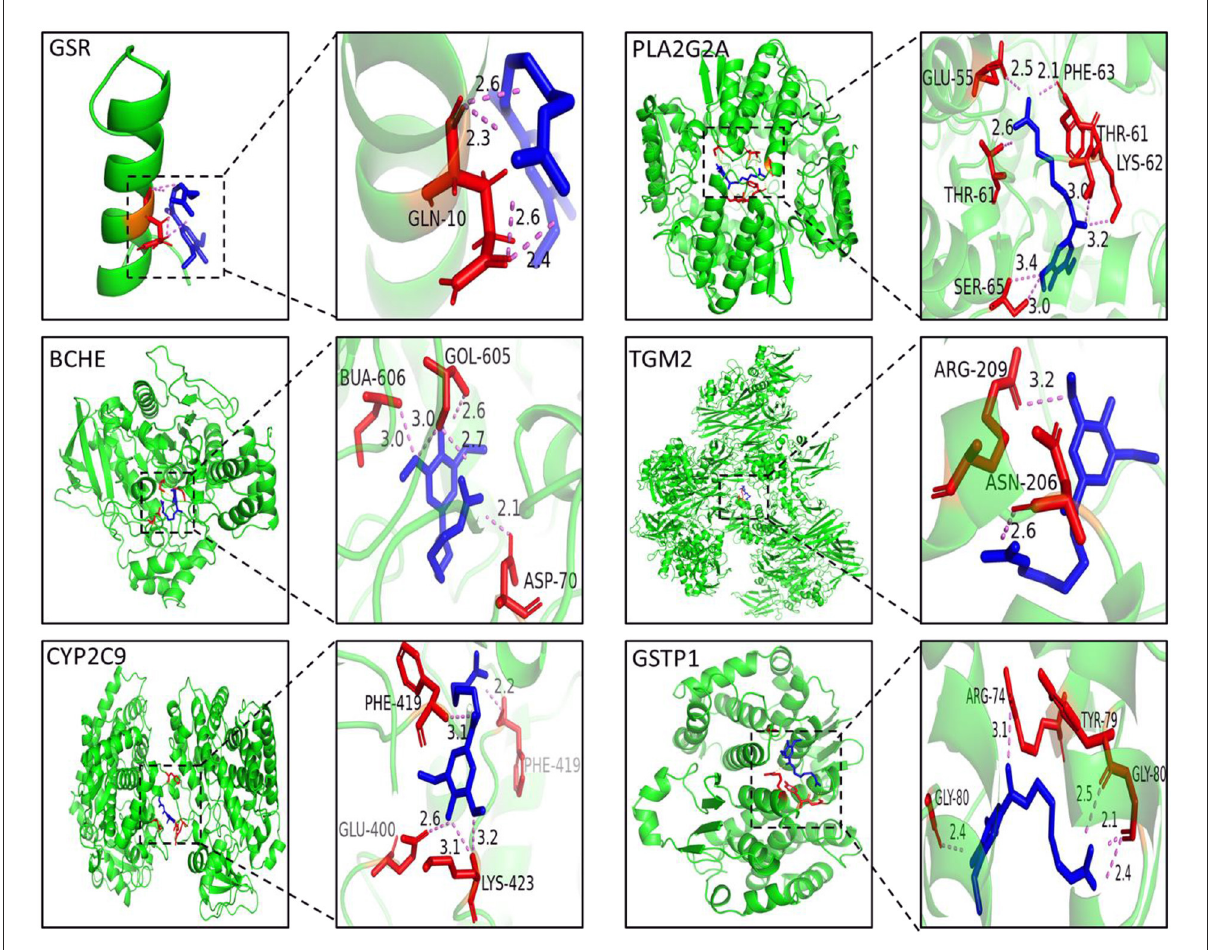
FIGURE5 The 3D interaction diagrams of leonurine and GSR, BCHE, CYP2C9, PLA2G2A, TGM2 and